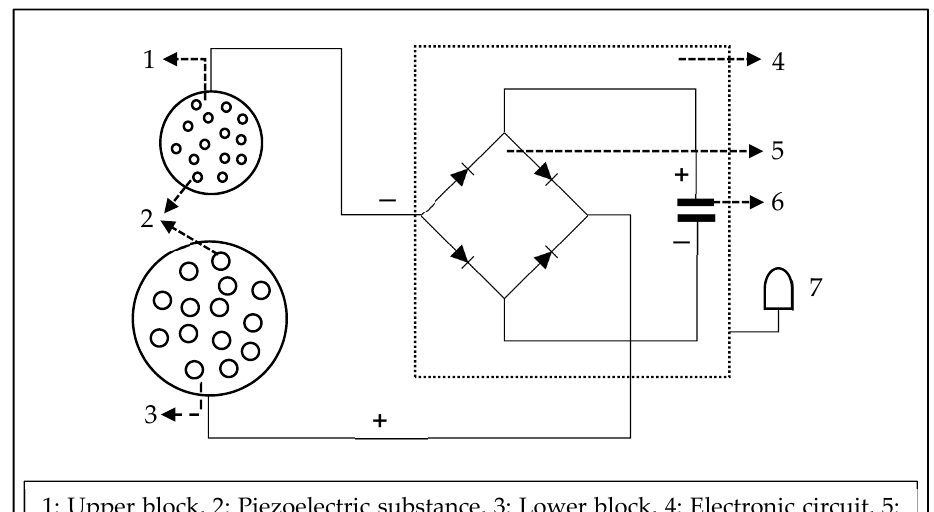
Figure 1. Illustration of the main components [18].